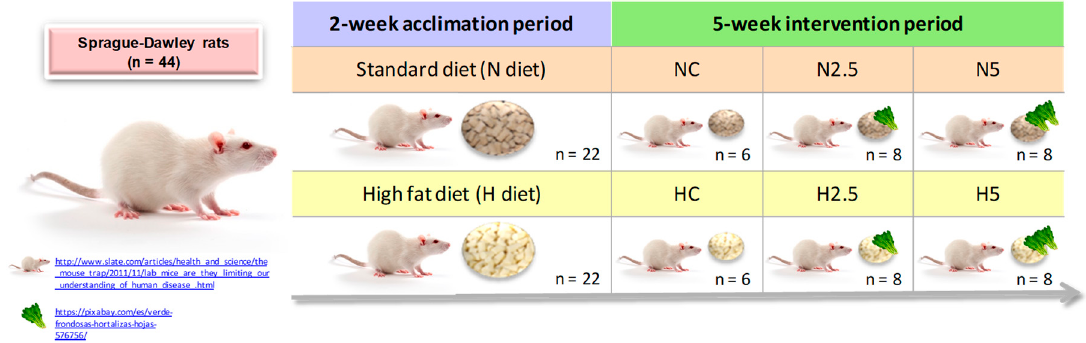
Figure 7. Experimental design of the study.